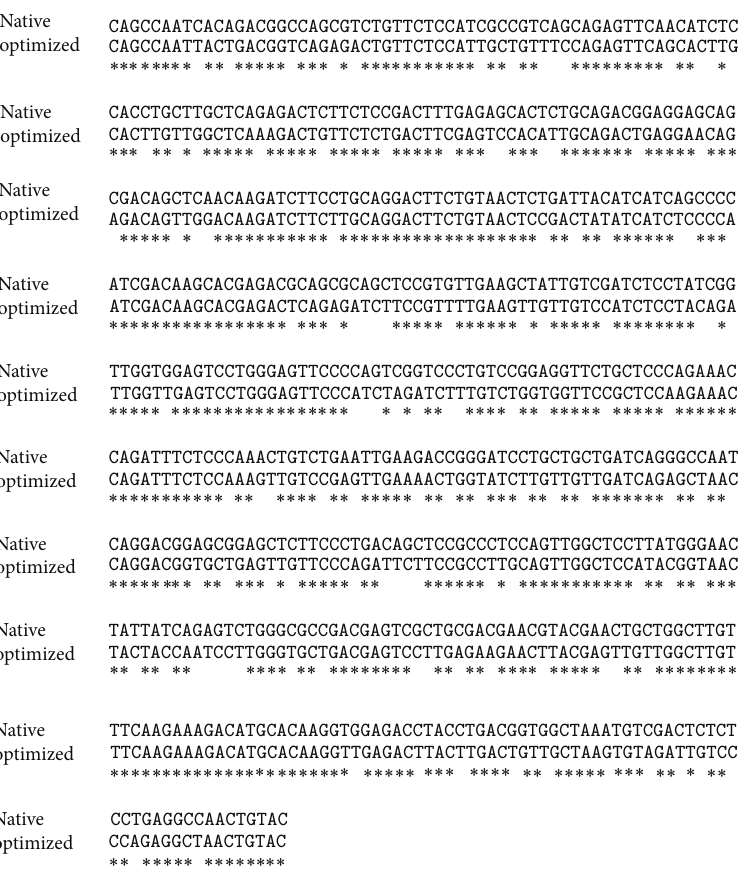
Figure 1: Sequences aligmnent of native fish growth hormone (nFGH) and optimized sequence based on P. pastoris preferred codons.